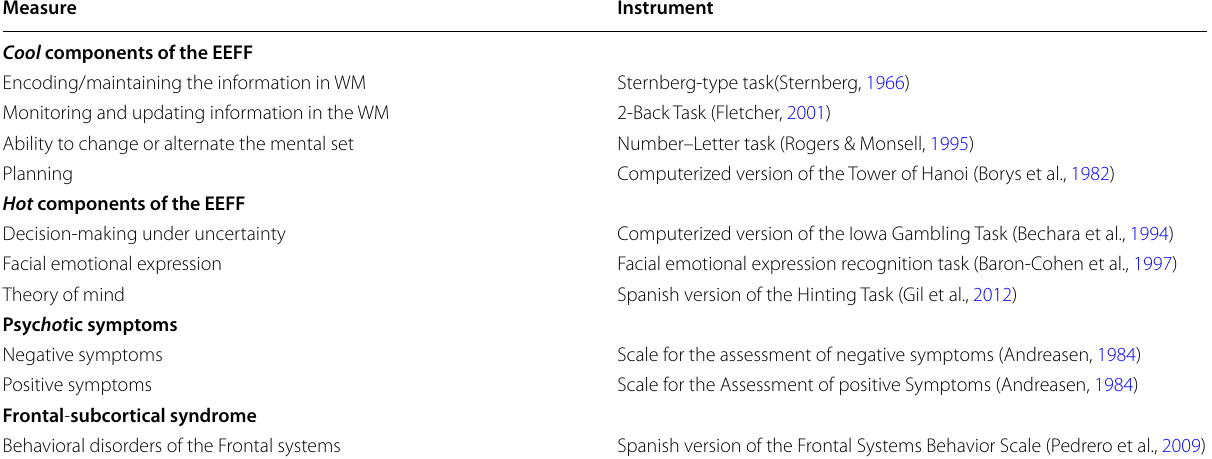
EEFF: executive function; WM: working